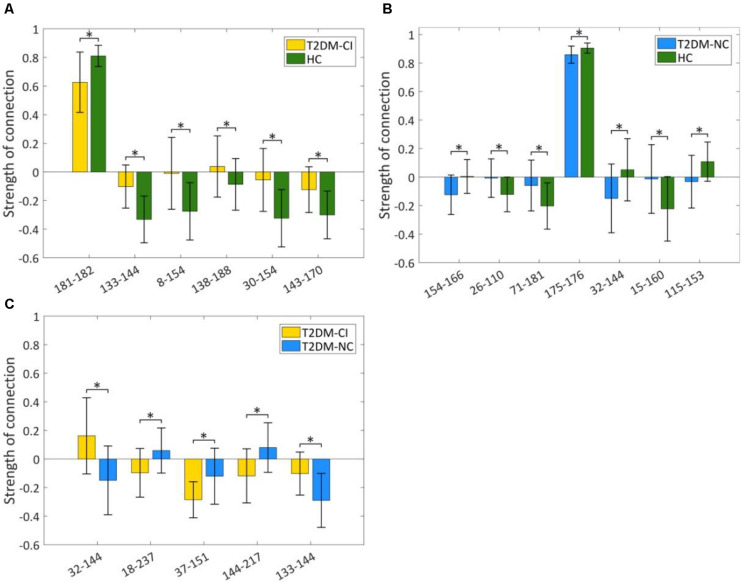
Strength comparison of dysfunctional discriminative connections. (A) Six connections for T2DM-CI versus HC; (B) Seven connections for T2DM-NC versus HC; (C) Five connections for T2DM-CI versus T2DM-NC. * indicates a difference of p < 0.05, which is statistically significant.